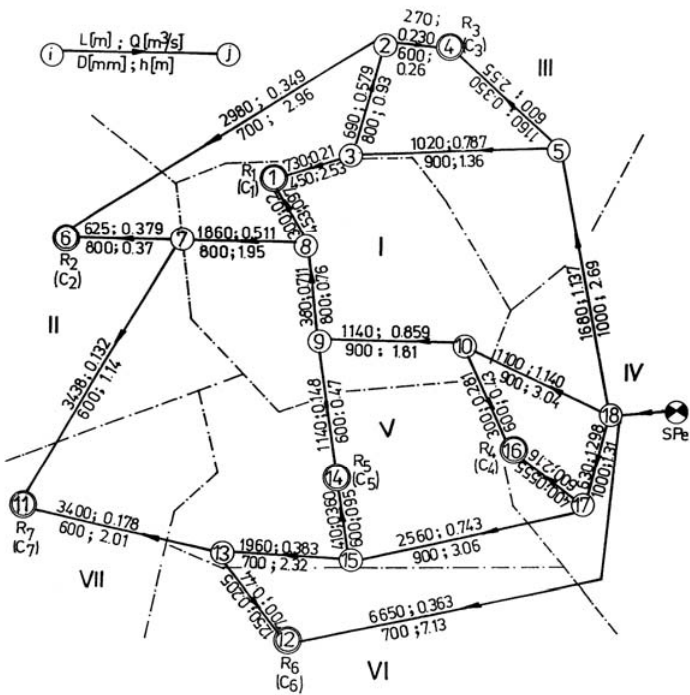
Figure 9. Schematic of the supply network of pumped storage tanks.